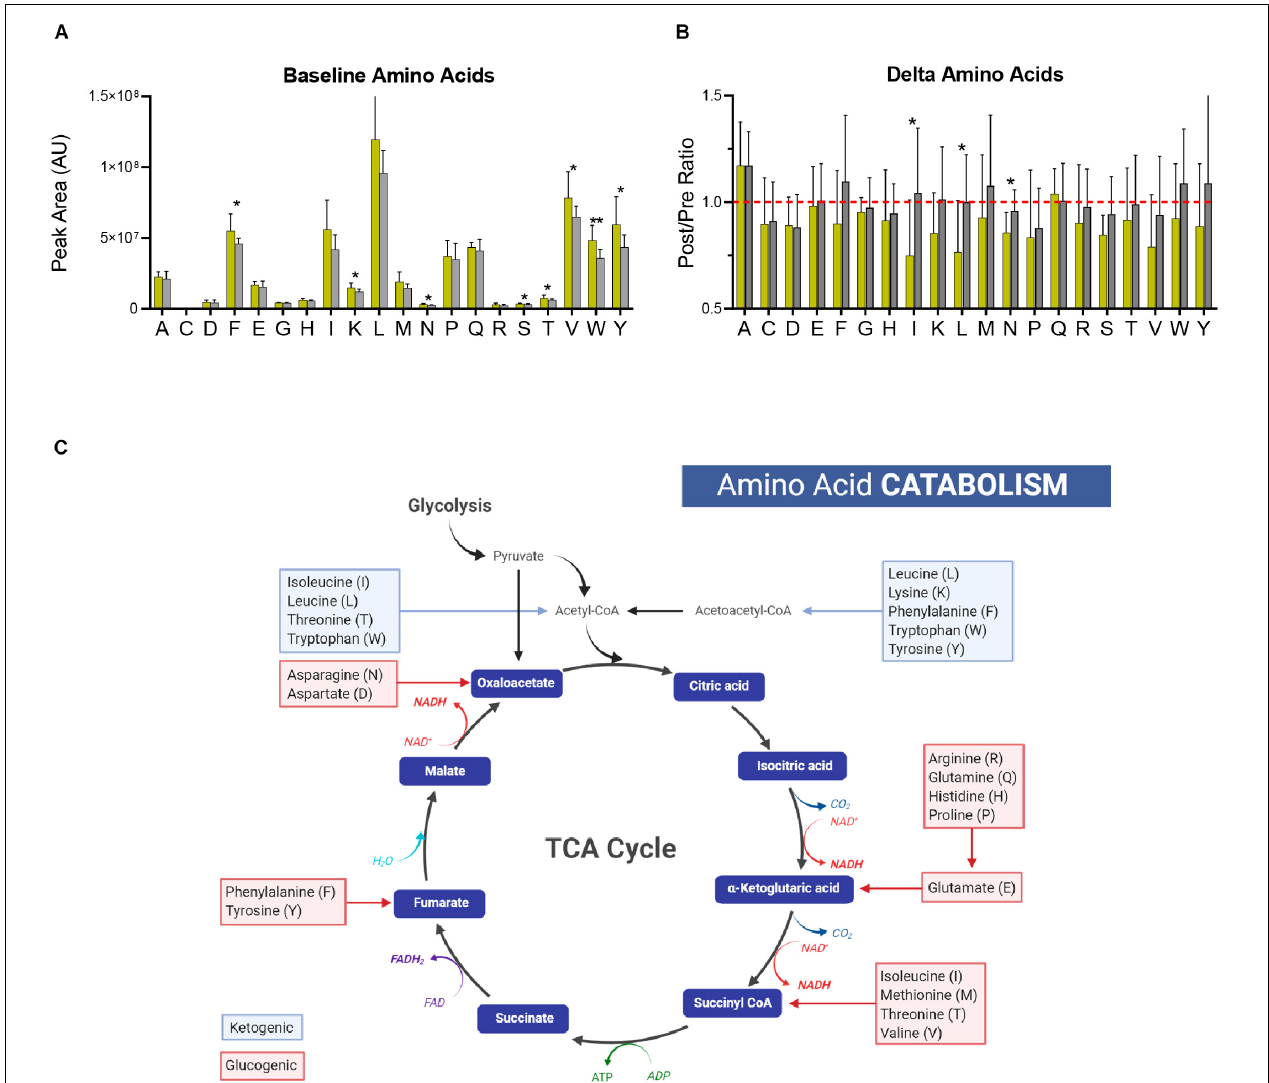
FIGURE 6 | Amino Acid Catabolism. (A) The baseline (pre-training) levels of amino acids (labeled with single letter code) are shown for the Gold and Silver performance groups. (B) Fold changes of amino acid levels (Post/Pre) for both performance groups are shown. A ratio of 1 is indicated by a dashed red line. (C) A generalized schematic of amino acid catabolism through the TCA cycle is shown. Glucogenic amino acids, which have the capacity to fuel gluconeogenesis, are listed in red boxes. Ketogenic amino acids, which contribute to acetoacetate and acetyl-CoA pools, are listed in blue boxes. p -values from a two-tailed Student’s T -test are shown as * p < 0.05; ** p < 0.01; *** p < 0.001; **** p <